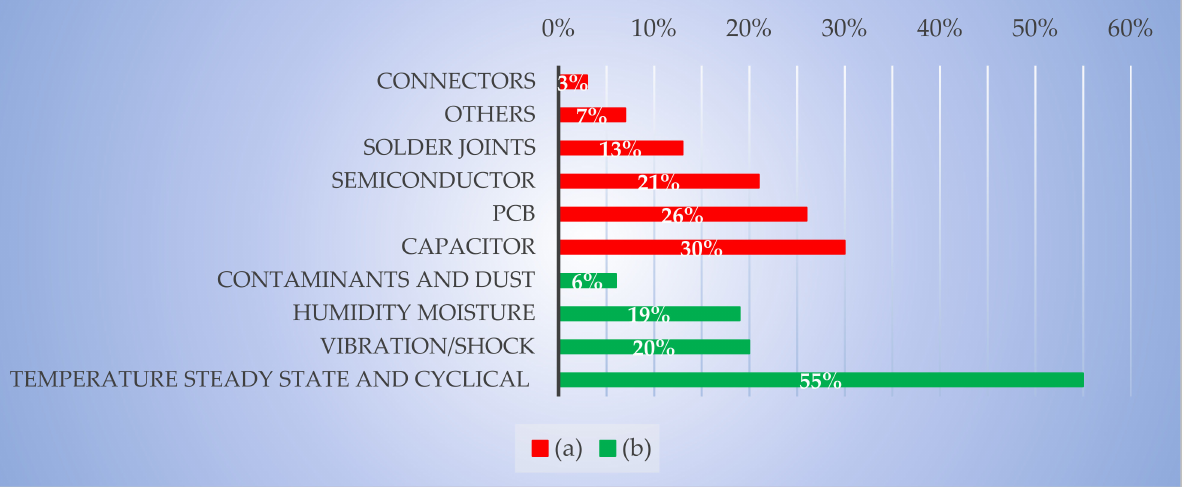
Figure 3. Analyses of failures in power conversion systems. ( a ) Failure distribution among the main components; ( b ) Source of